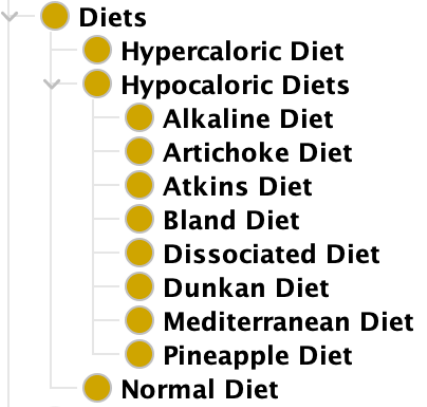
Figure 2. Diets’ hierarchy defined in the ODR.